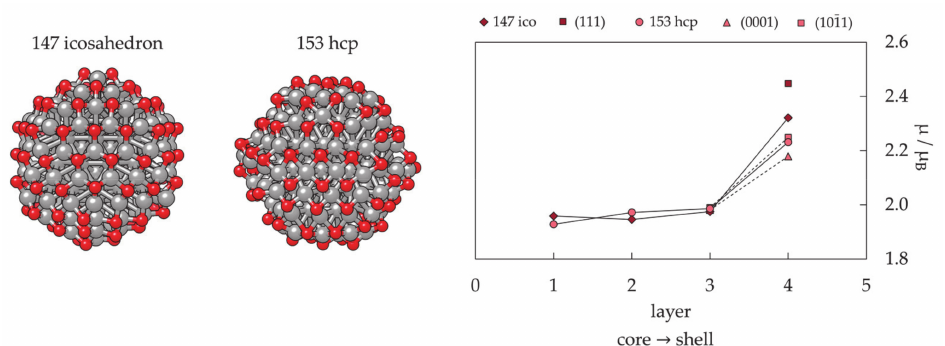
Figure 14. Structures of oxidised 147-atom icosahedron and 153-atom hcp Co mNPs ( left ) and corresponding layer-averaged magnetic moments per Co atom with core-to-surface progression, 1 being the core atom and 4 being the outer shell layer ( right ). Average magnetic moments of ( 111 ) , ( 0001 ) , and (cid:0) 1011 (cid:1) facets are also given. DFT results indicate that the Co mNPs with hexagonal symmetry have the highest MAE values of 1412.5 kJ/m 3 for 0.8 nm and 397.9 kJ/m 3 for 1.3 nm diameter